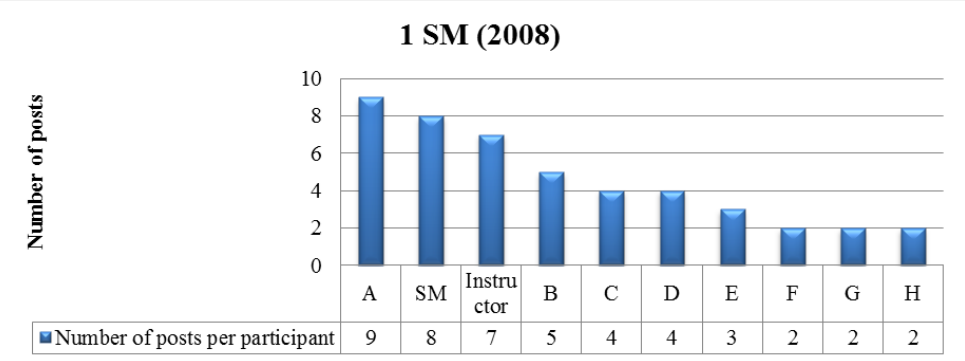
Figure 1 . Number of posts per participant of 1 SM forum.